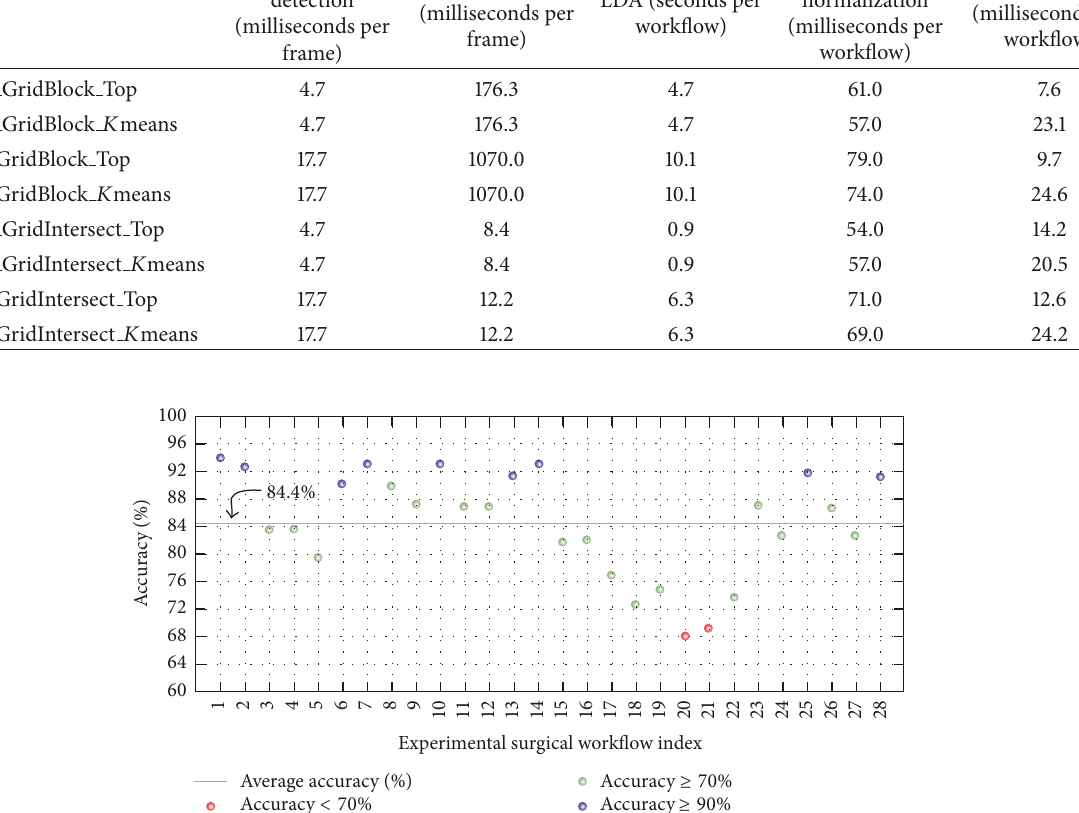
Figure 17: Accuracy in each surgical workflow of FrameDiff GridBlock Kmeans when 𝐾 was 20 and 𝑐 was 230.